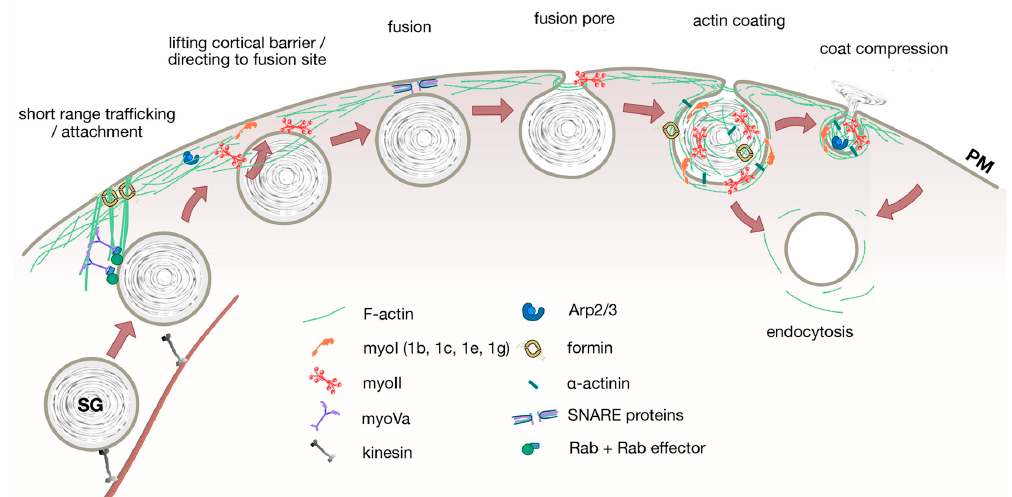
Figure 1. A simplified model of the roles of actin and myosins in non-neuronal exocytosis.The scheme depicts potentially conserved or common mechanisms that have been observed in at least two di ff erent secretory cell types. Secretory vesicles are usually transported to the cell periphery on microtubules by motor proteins kinesins. Once in close proximity to the cell cortex, secretory vesicles might be guided towards (and attached to) the cortex by myoV motors along actin bundles attached to the PM. Actin cortex remodeling by myoII and possibly also myoI is necessary to enable access of large secretory vesicles to the PM for fusion of vesicles with the PM. The cortical actin network is essential to direct exocytic vesicles to the fusion site and for stable attachment or docking of granules close to the PM to facilitate fusion via SNARE proteins. F-Actin and myosin also provide force to modulate fusion pore diameters. Actin is polymerized on fused vesicles. Myosins are then recruited to the “actin coat” to either generate compressive forces for active secretion of vesicle contents or integration of vesicle membrane against a high hydrostatic pressure into the PM, likely in conjunction with an actin polymerization / crosslinking mechanism. In some cells, actin coats also stabilize fused secretory vesicles for endocytic